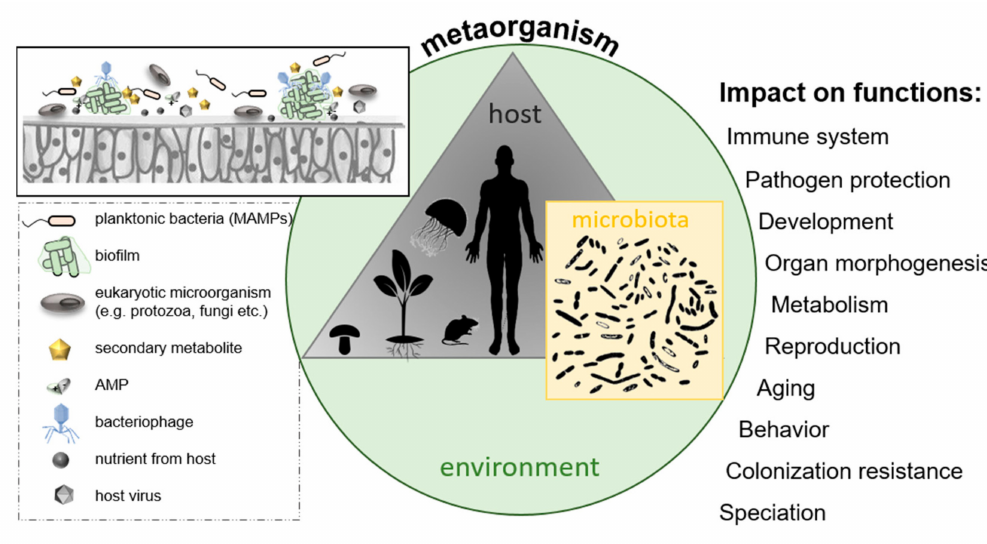
Figure 7. The metaorganism concept; a metaorganism consists of a multicellular host and its associated microbiota located in a specific environment. Selected factors are presented that might influence bacterial colonization of host surfaces, ultimately affecting various host